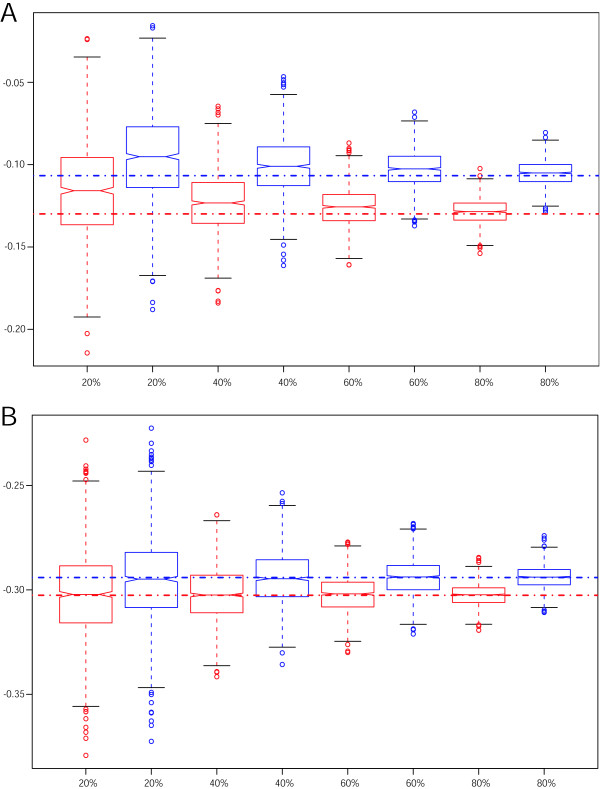
Correlation between evolutionary rate and degree and expression level. (A) The boxplots of Kendall's rank correlation coefficient (red) show a weak anti-correlation between evolutionary rate and degree, which increases with subnet size. The corresponding partial correlation coefficients (blue) indicate a weaker anti-correlation when protein expression level is controlled for. (B) Correlation coefficients (red) between evolutionary rate and protein expression level and partial correlation coefficients (blue) which account for differences in protein degree. The anti-correlations found here are stronger than those shown in part A of this figure. The horizontal dot-dashed lines represent the correlation coefficients of the full network.